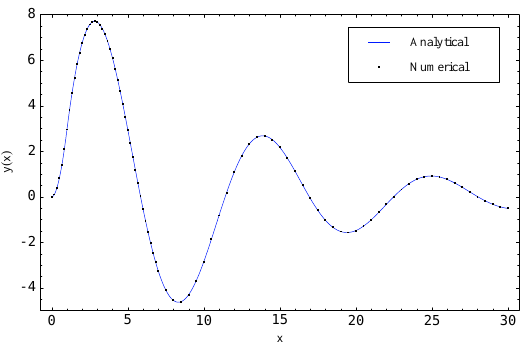
Fig. 5: Comparison of the present numerical solution and the analyt- ical solution for Example